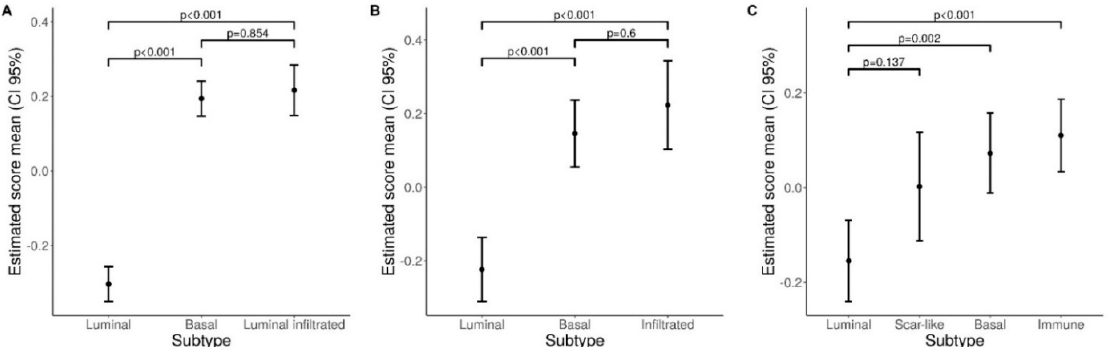
Figure 9. Chemokine signature in datasets. Plots show estimated mean score values and corresponding 95% confidence intervals for Chemokine GSE scores in bladder subtypes ( A TCGA, B GSE32894, C GSE124305). Pairwise comparisons p-values were computed from linear models and adjusted for multiple comparisons.